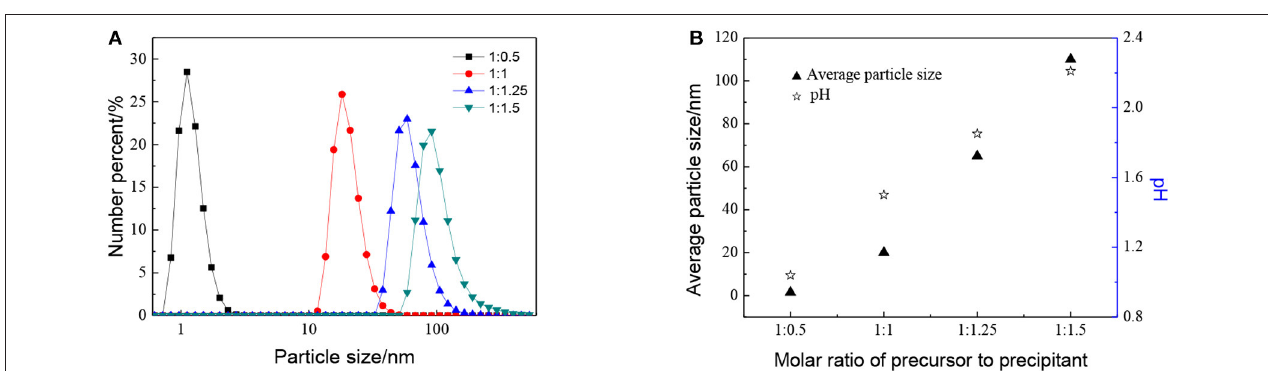
FIGURE 2 | Effect of different molar ratio of precursor to precipitant on (A) particle size distributions and (B) average particle size and pH of ZrO 2 sols at ultrasonic power of 90% and ultrasonic time for